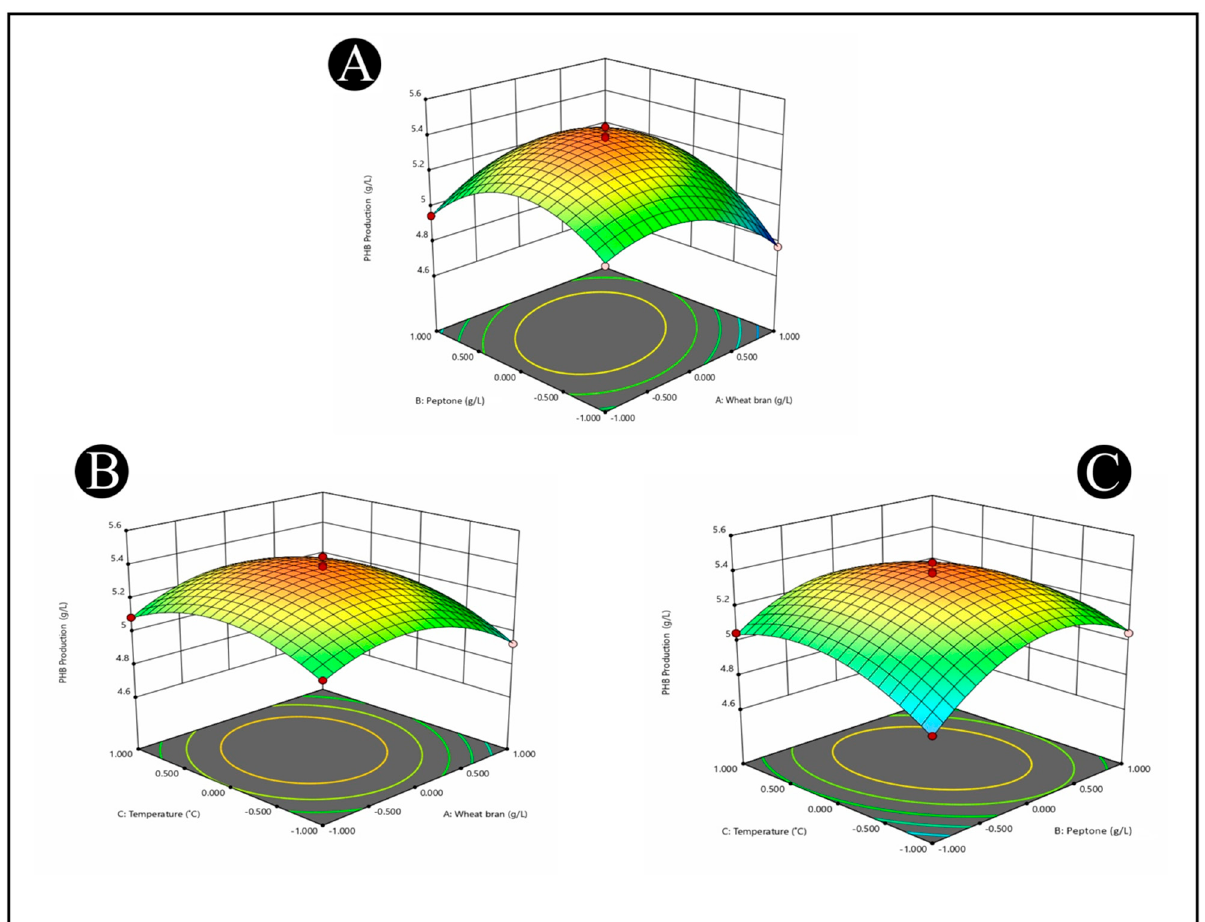
Figure 6. 3D surface plots representing PHB production from the culture broth of B. fl exus strain HSA3 as affected by cultural conditions of ( A ) wheat bran peptone, ( B ) wheat bran and temperature, and ( C ) peptone and temperature.